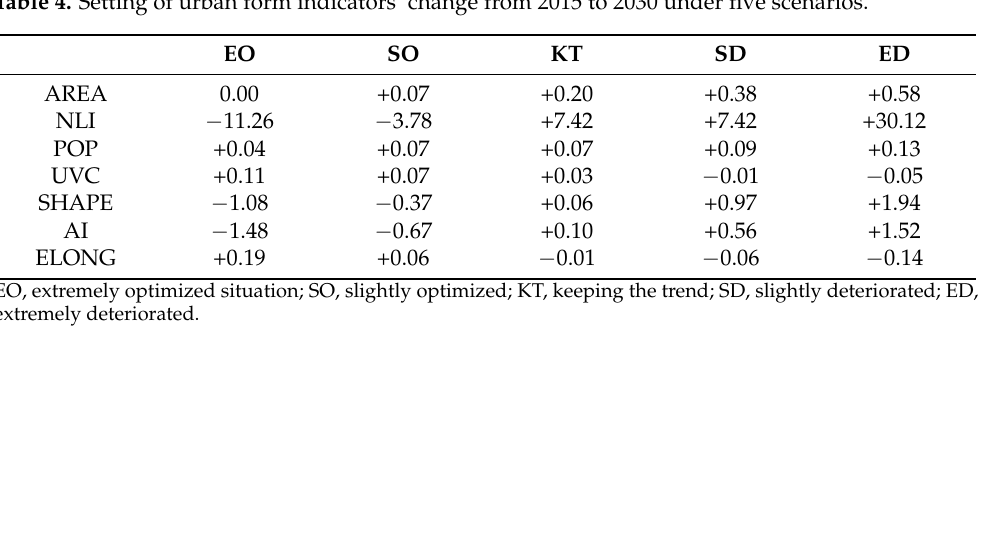
Table 4. Setting of urban form indicators’ change from 2015 to 2030 under five